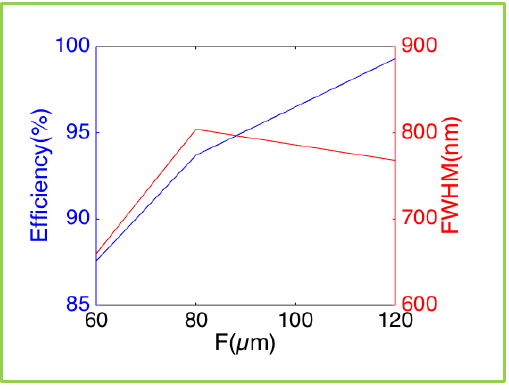
Figure 6. Focusing efficiency and FWHM of focus spot as function of the meta-less’ focal length f.